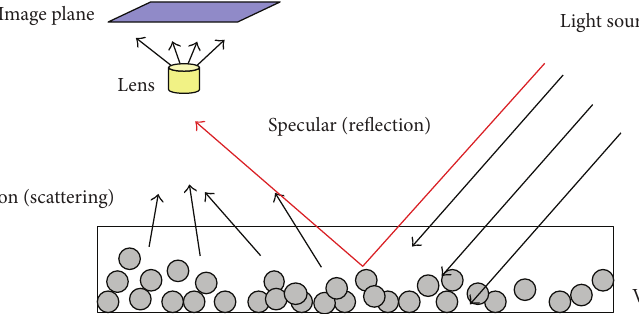
Figure 4: Reflection and scattering of the lunar surface.